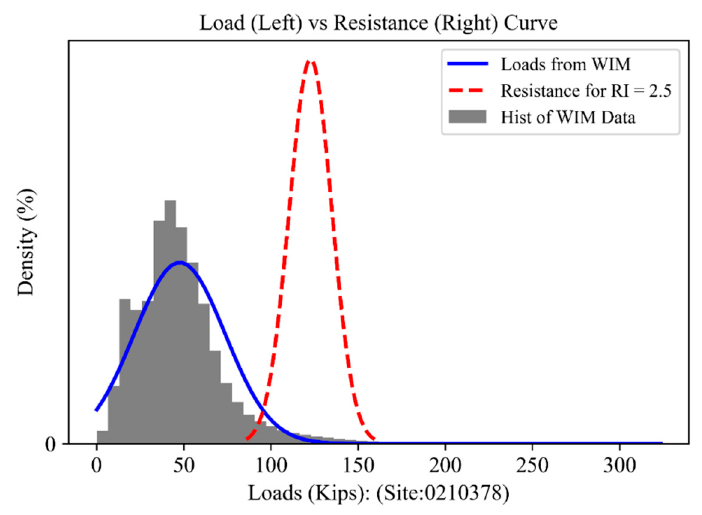
Figure 5. WIM live load histogram fitted with normal distribution and NBI OR distribution.